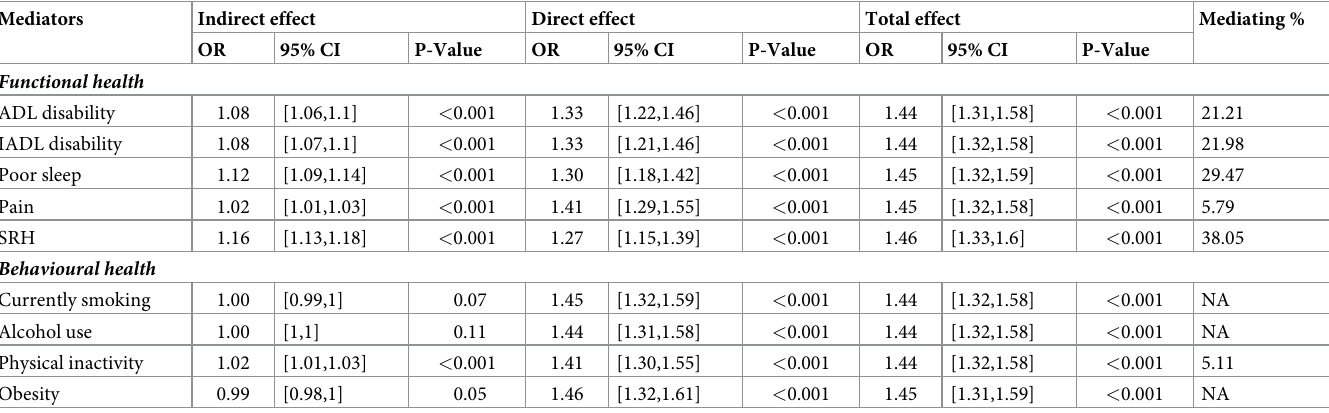
Table 4. Functional and behavioural mediators in the association between multimorbidity and depression (Men).